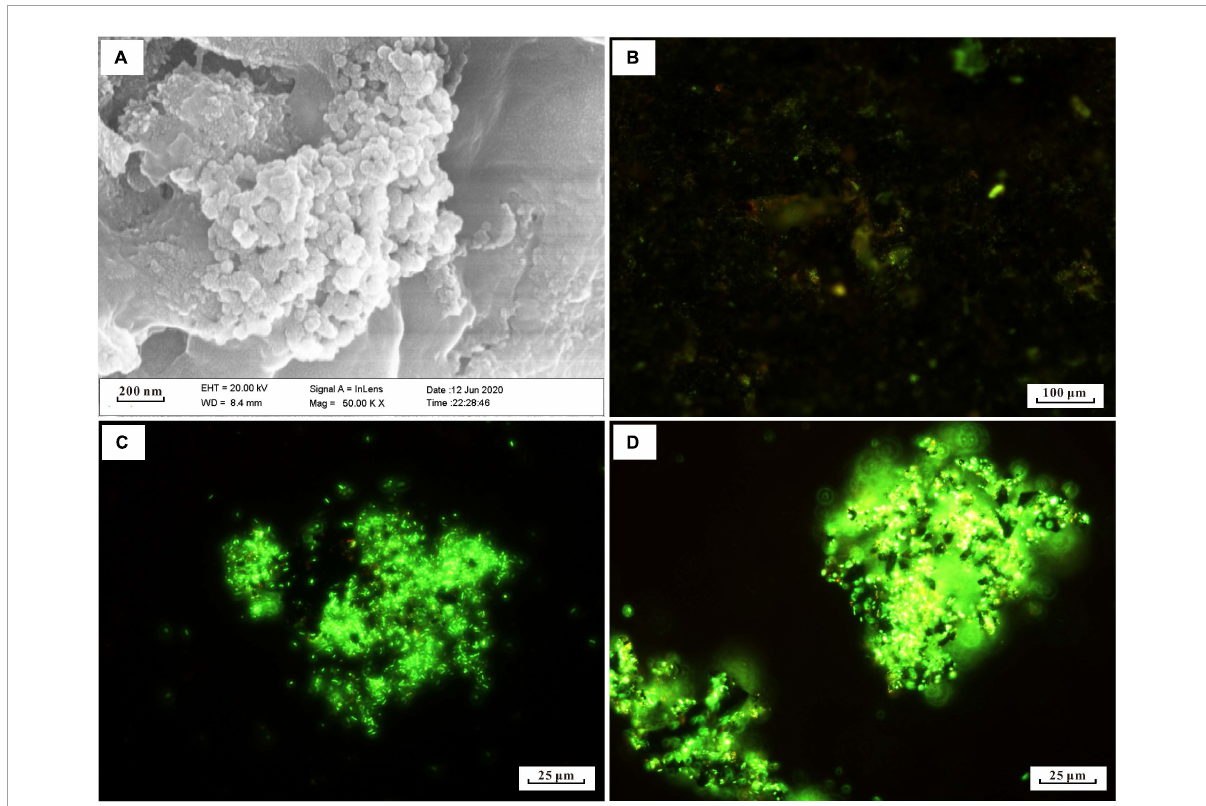
FIGURE1 Microscopy images of biomineral structures characteristic and SYTO 9-stained cells of in situ enrichment slab surface and enrichment culture incubated with modified MMJHS medium, (A) SEM image of biomineralization with short stalk and cocci structure in slab. The SEM observation was performed at 20 kV with a working distance of 8.4 mm. SYTO 9-stained cells in (B) in situ enrichment slab; (C) original enrichment culture, and (D) secondary enrichment culture. Scale bars: (A) 200 nm; (B) 100 µ m; (C,D) 25 µ m.